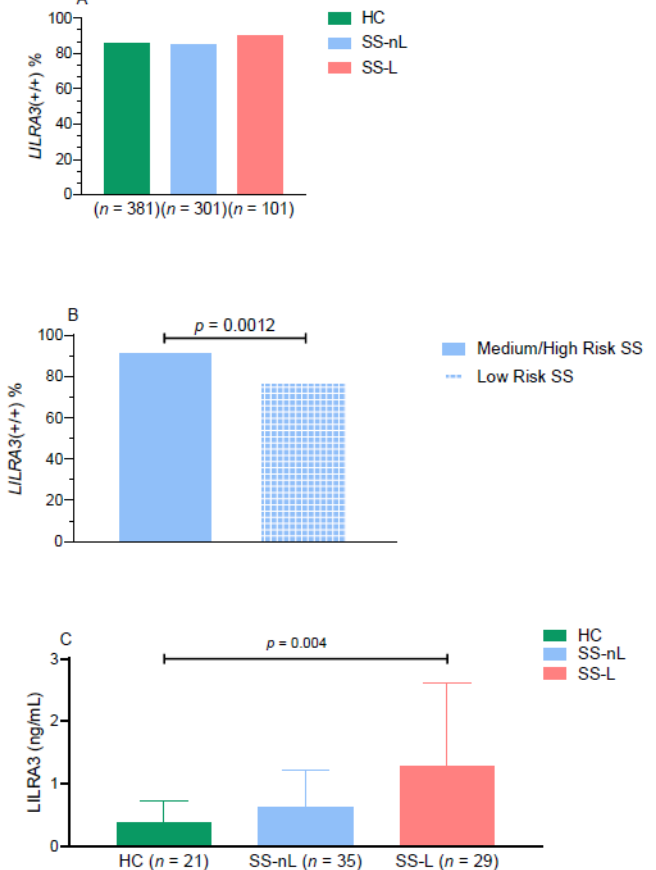
Figure 1. ( A ) Frequency of the LILRA3 wild type variant among distinct SS subsets in comparison to HC. ( B ) Statistically increased frequency of wild type LILRA3 was detected in medium/high risk group compared to low risk SS patients. Stratification of SS patients was based on the number of adverse predictors for lymphoma development at diagnosis ( ≤ 2 risk factors: low risk, >2 risk factors: medium/high risk. ( C ) Serum levels of LILRA3 protein in distinct SS subsets and HC. LILRA3: leukocyte immunoglobulin-like receptor A3; SS-nL: Sjogren’s syndrome non-lymphoma patients; SS-L: Sjogren’s syndrome lymphoma patients; HC: healthy controls.